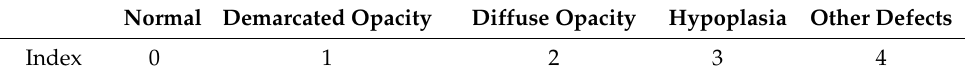
Table 1. Modified DDE